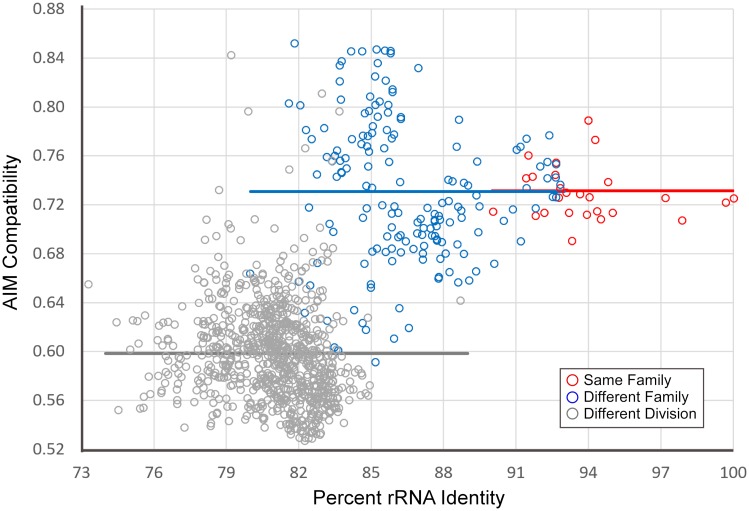
Compatibility of sets of AIMS within potential donor genomes to the AIMS found in the genome of Bacillus subtilis 168.The strand-bias of AIMS native to B. subtilis is plotted against the 16S rRNA identity between potential donor and recipient genomes. Lower values indicate that the AIMS in the recipient genome are less strand-biased in the donor genome. The red markers indicate donor genomes in the same family, the blue markers indicate donors in same division, but different family, and the gray markers indicate donors in different divisions. The red lines indicate least-squares linear regressions. Horizontal lines indicate mean compatibilities within each of these three groups.